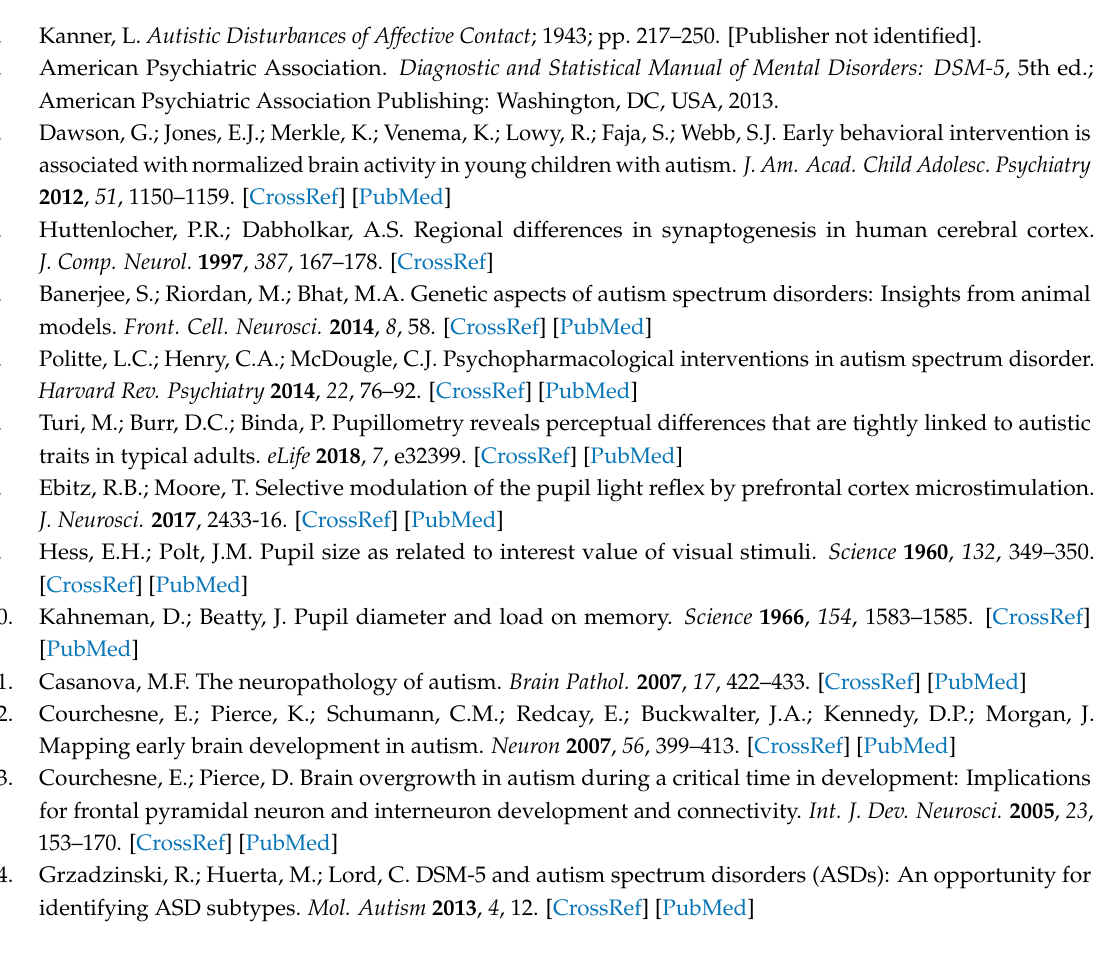
s1, Table S1: PLR studies by sample size, PLR measures, and main